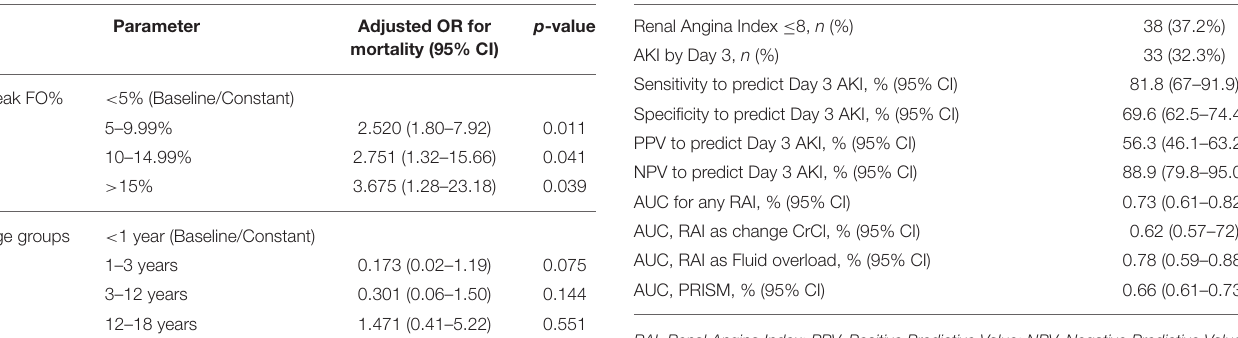
TABLE 8 | Value of renal angina index to predict AKI and